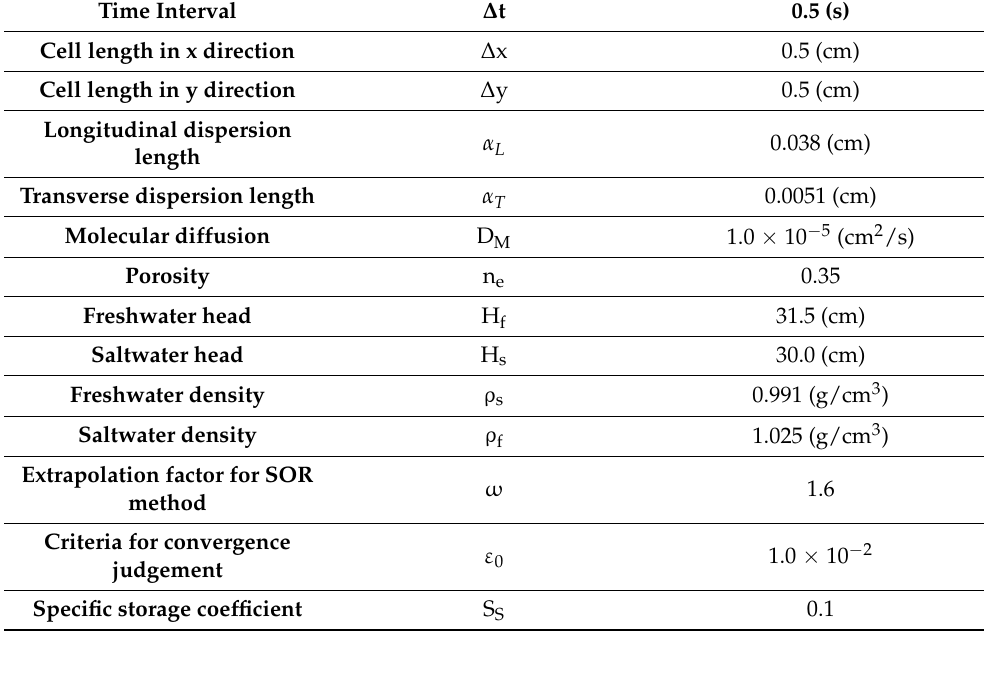
Table 3. Numerical and hydrological parameters for simulation.